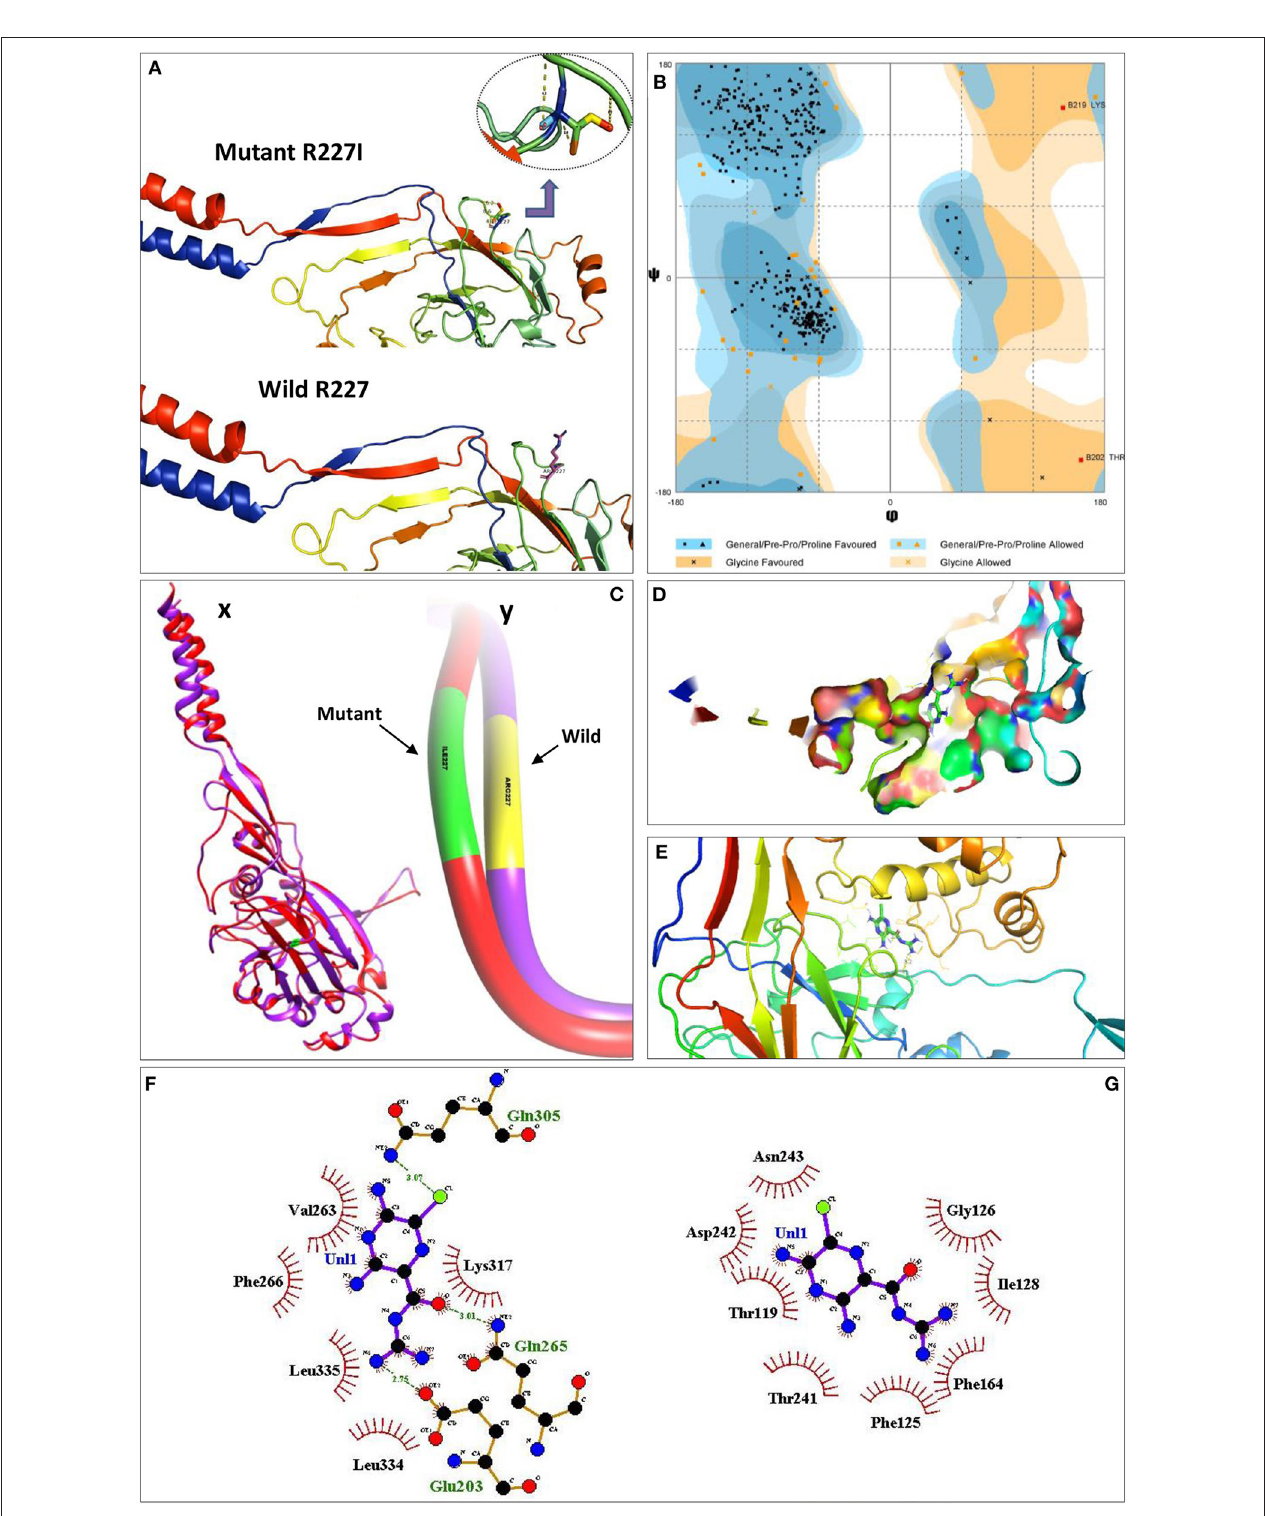
FIGURE 2 | Pathogenicity analysis of R227I mutation in the ASIC5 protein through molecular docking and interaction analysis. (A) Structural models of the wild (R227) and mutated (R227I) ASIC5 proteins. (B) Ramachandran plot for the predicted structure of the ASIC5 protein. Eighty-three porterage residues of the ASIC5 protein are in the most favored regions. Cx, superimposed structures of the wild (R227) and mutated (R227I) ASIC5 proteins; Cy, deviated region of R227I from R227 on superimposed wild and mutant ASIC5. (D) Amiloride with ASIC5 at the active binding site. (E) 3D amiloride with surrounding amino acids of ASIC5 protein. (F,G) Protein–ligand interaction. (F) Wild ASIC5 (R227) protein with ligand, amiloride. (G) Mutant ASIC5 (R227I) protein with ligand, amiloride.